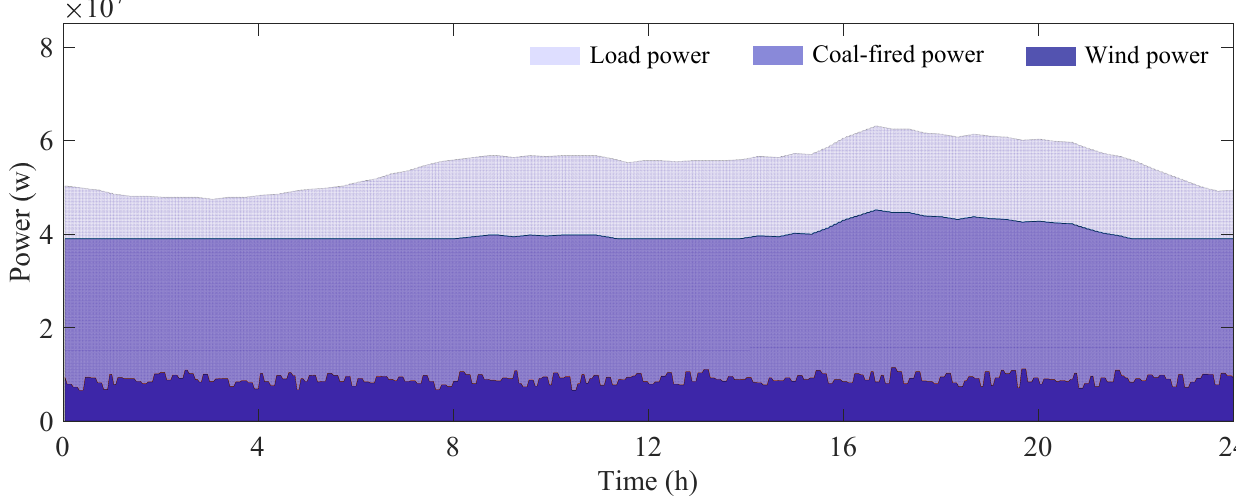
Figure 10. Hourly variety rules on a typical day with respect to the coal-fired power, wind power and load demand of a power station. The “W” is the short for the unit of coal-fired power, wind power and load demand, and the “h” is the short for the time unit.